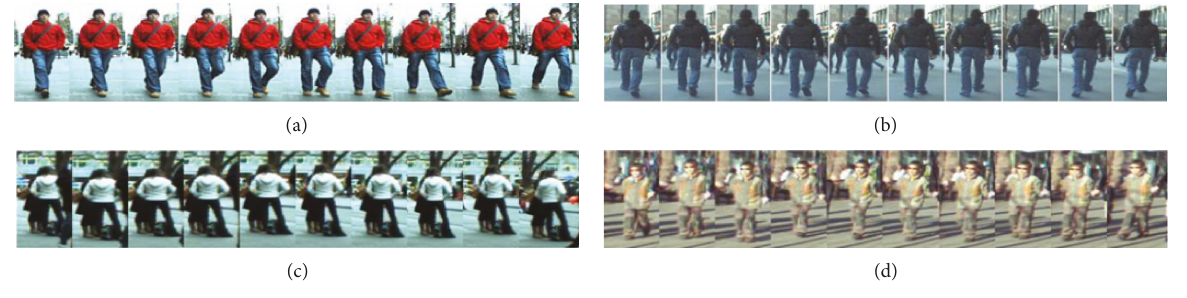
Figure 3: Image examples of the ETHZ